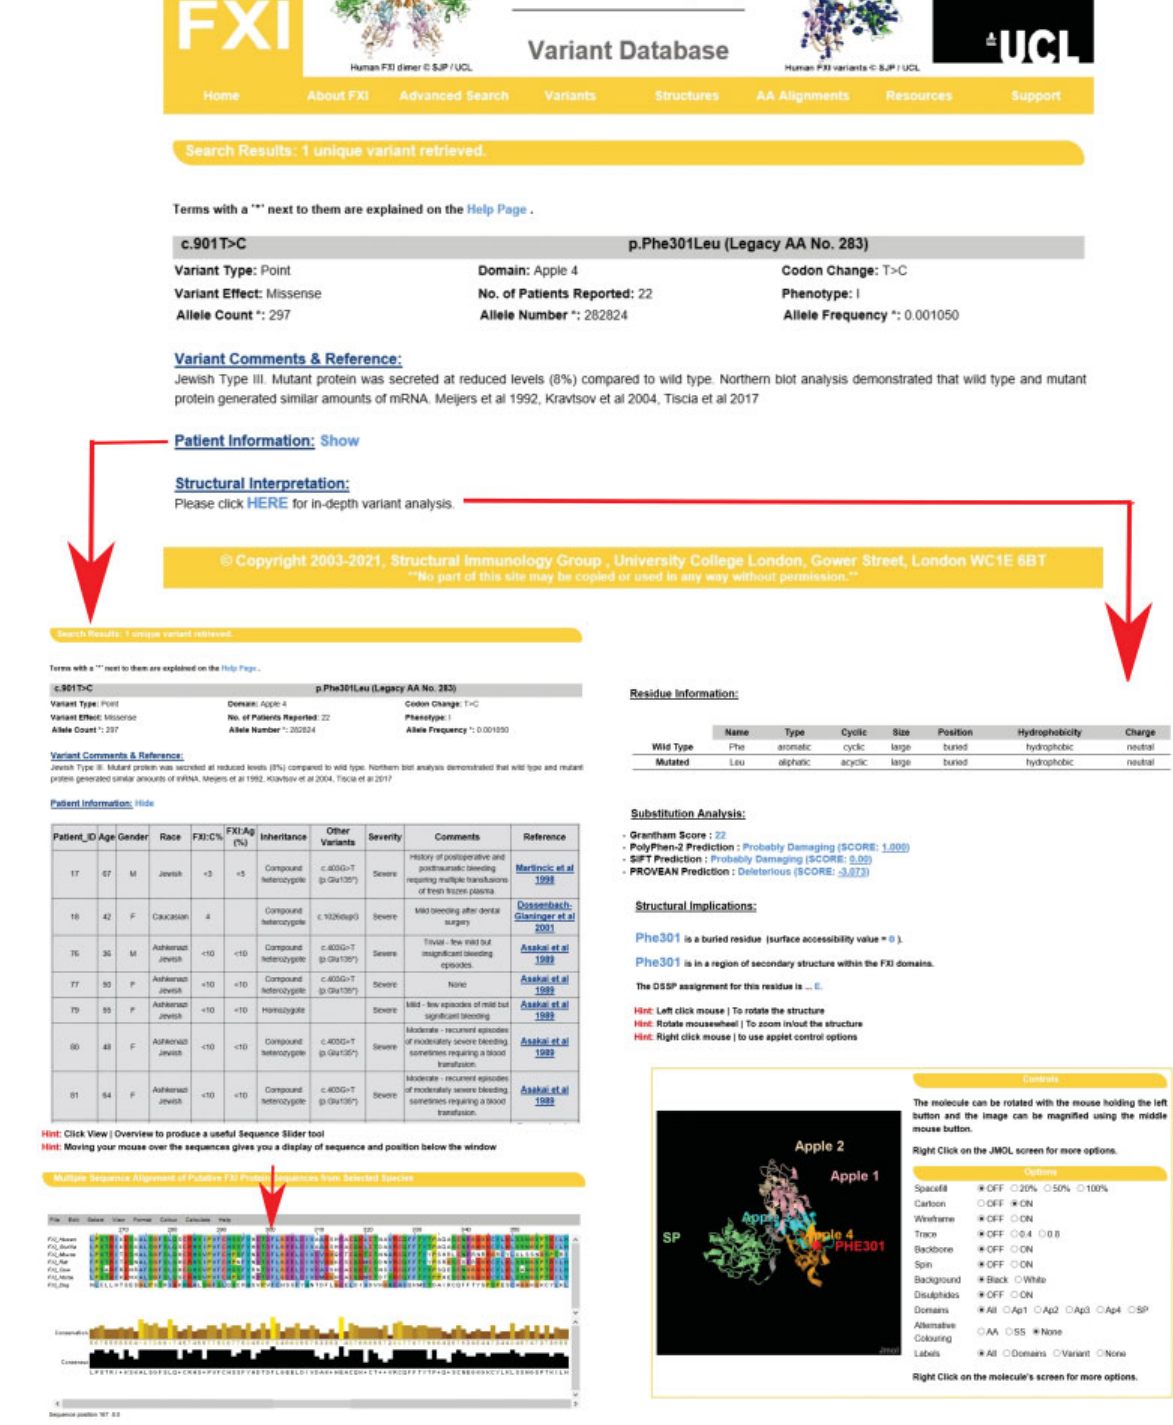
Fig. 10 Screenshots of the upgraded FXI website to illustrate the analysis made for the Phe301Leu variant. The upper panel displays the output when residue 301 is inputted on the home page. By clicking “ Show ” on the patient information, the lower left panel lists genetic information for the 22 patients reported with Phe301Leu variant, of which the fi rst fi ve records are visible, together with the source of the patient record. The sequence alignment is shown underneath with Phe301 highlighted. Clicking “ HERE ” on the structural interpretation gives the image shown on the bottom right panel. This assesses the buried or exposed accessibility of the variant and its location in the FXI protein structure. A JMol view of the FXI structure is displayed that can be rotated and zoomed into as desired. The substitution analysis to predict the damaging effects of each missense variant (PolyPhen-2, SIFT, Grantham and PROVEAN) is provided to facilitate clinical diagnosis.